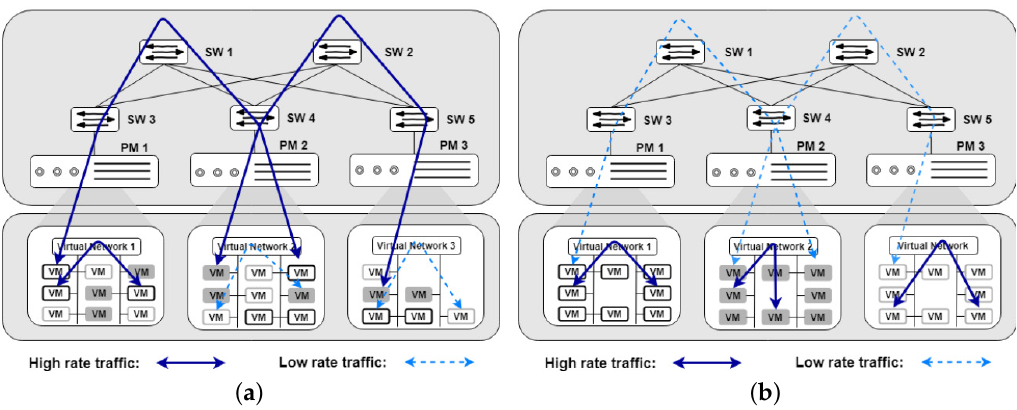
Figure 2. VM placement cases in data center. ( a ) random VM placement; and ( b ) traffic dependency based VM